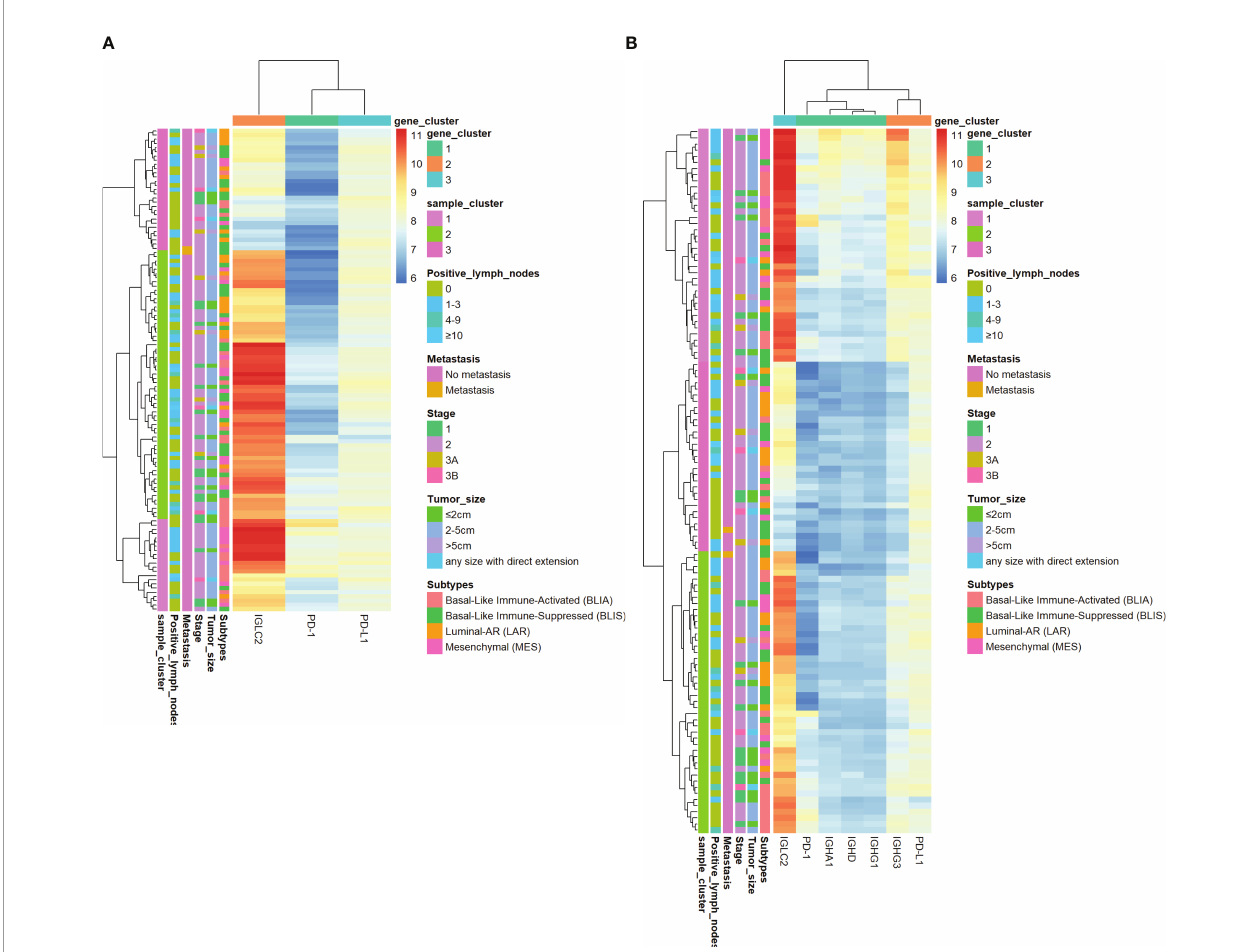
FIGURE 4 | Heatmap of log2 mRNA expression of IGLC2, PD-1, and PD-L1 of TNBC tissues using GSE 76275. (A) The heatmap of IGLC2, PD-1, and PD-L1, (B) The heatmap of IGLC2, other highly co-expressed immunoglobulin genes found in our previous study (26), PD-1, and